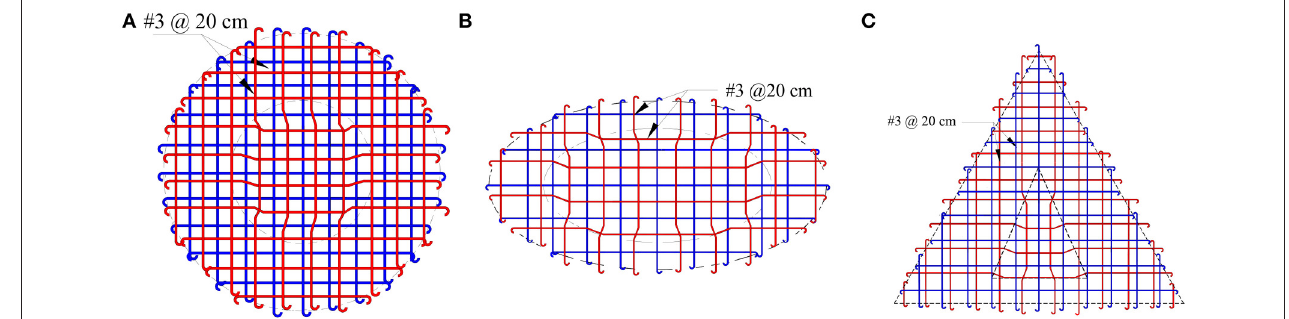
FIGURE 8 | Steel reinforcement layout in: (A) circular slab, (B) elliptic slab, and (C) triangular slab.